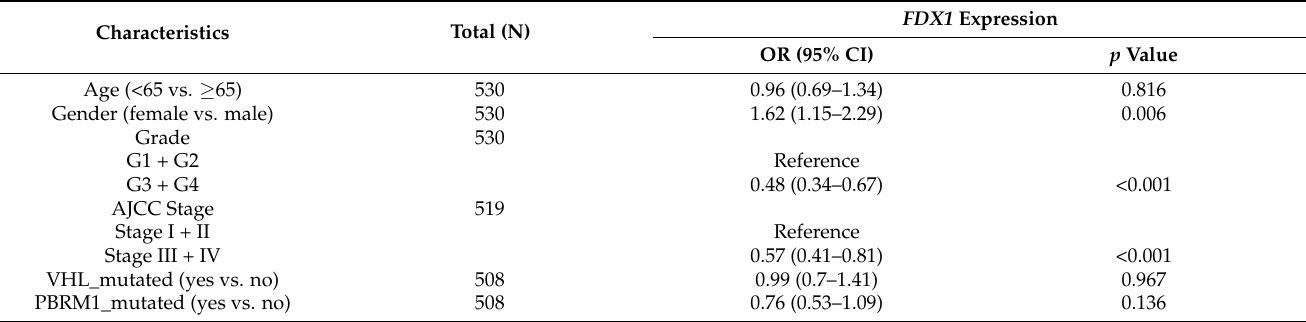
Table 1. The association between FDX1 expression and clinical characteristics.